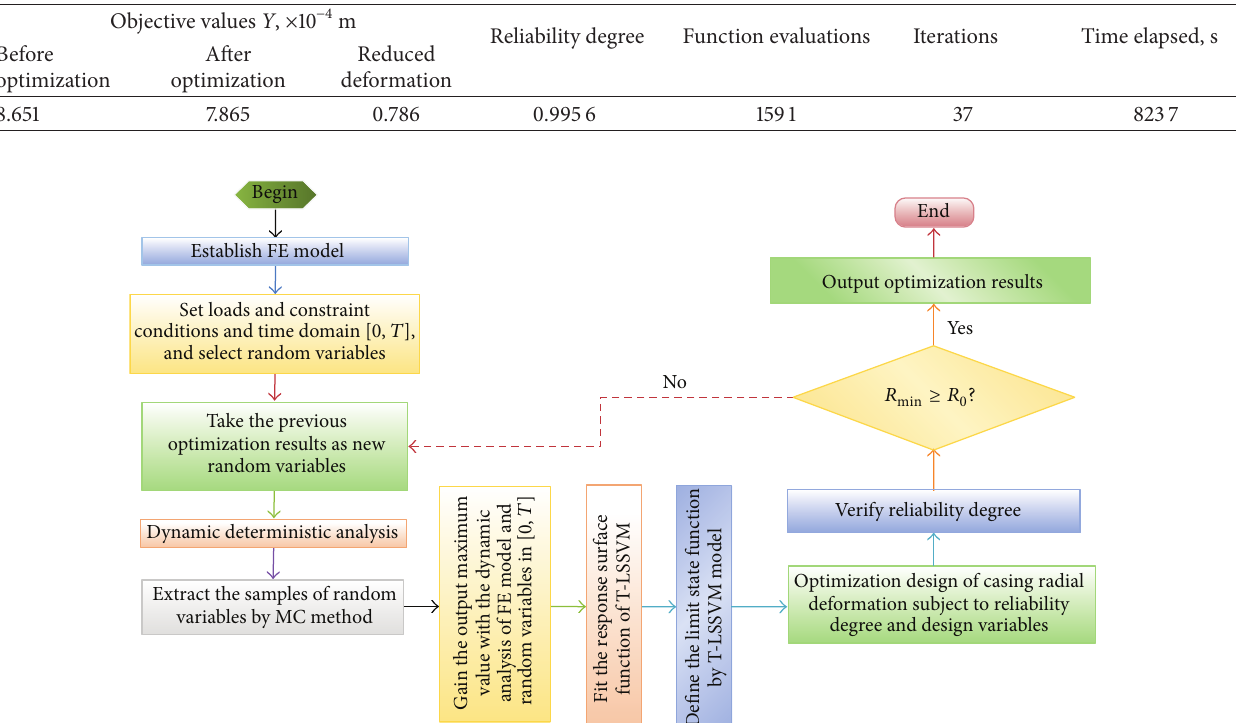
Table 5: Optimization results of casing radial deformation based on T-LSSVM.